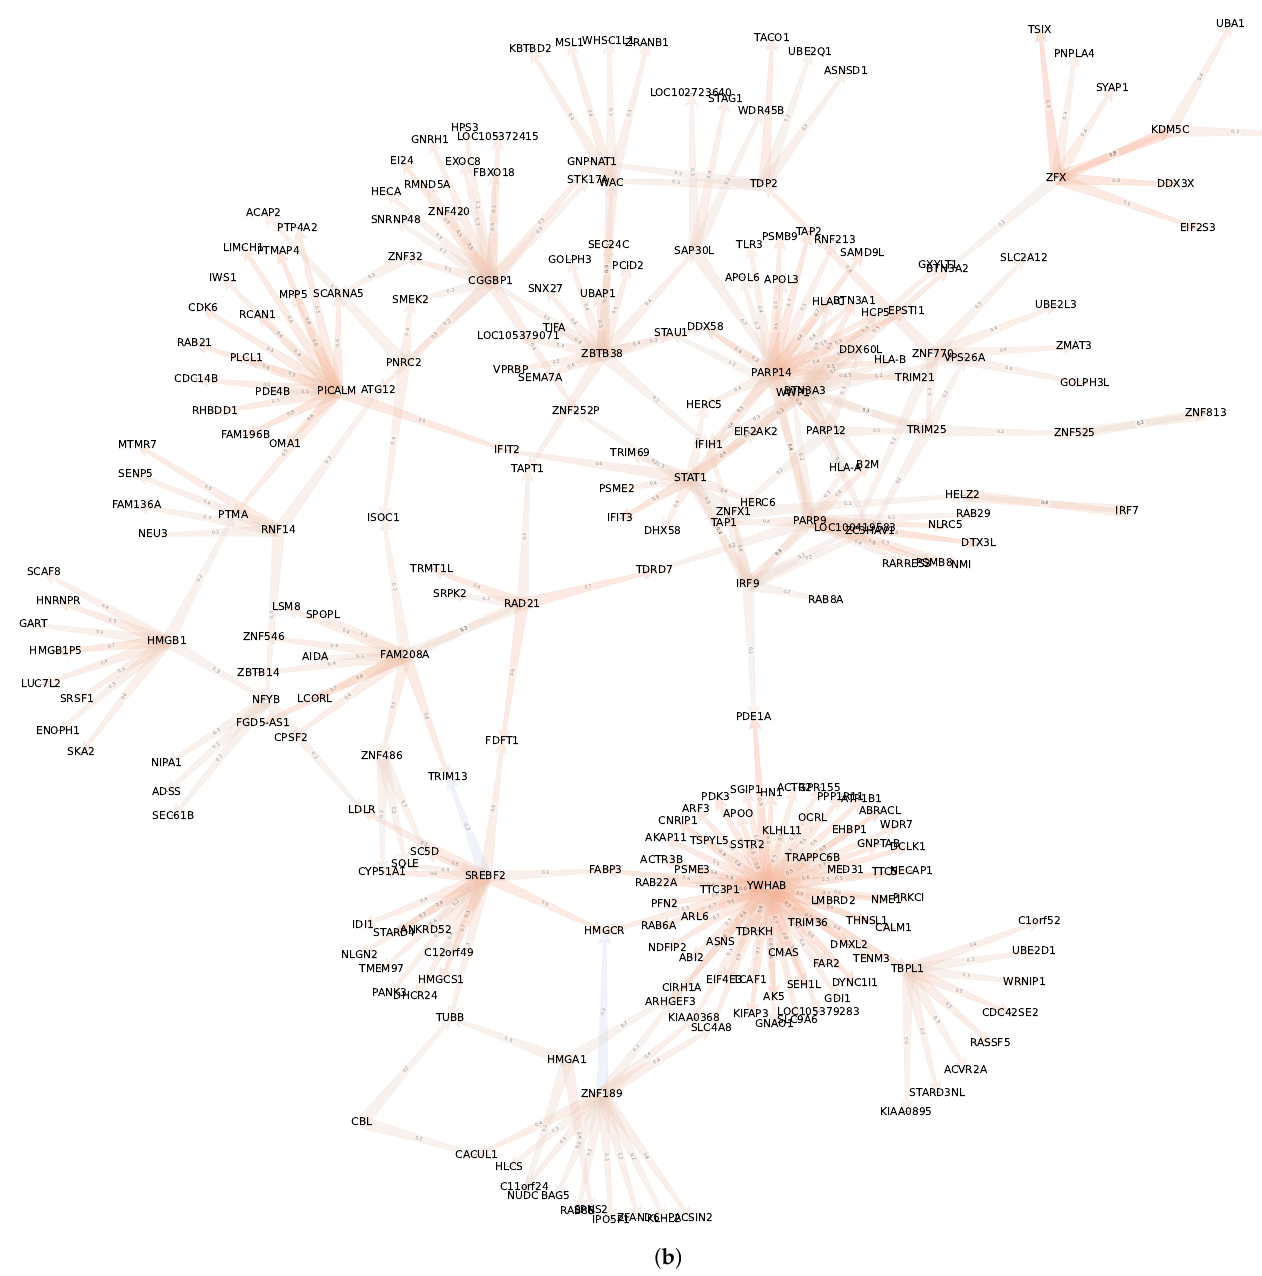
Figure 14. Regulatory communities Hs | 12 and Hs | 13, within the GXN•OMP obtained from the H. sapiens Alzheimer/Control dataset. Communities Hs | 12 is over-expressed in the control samples and under-expressed in Alzheimer disease samples, while community Hs | 13 depicts the opposite expression pattern. For the sake of clarity, we represent only the links with a coefficient higher than 0.2 in absolute values; ( a ) Community Hs | 12; ( b ) Community Hs |